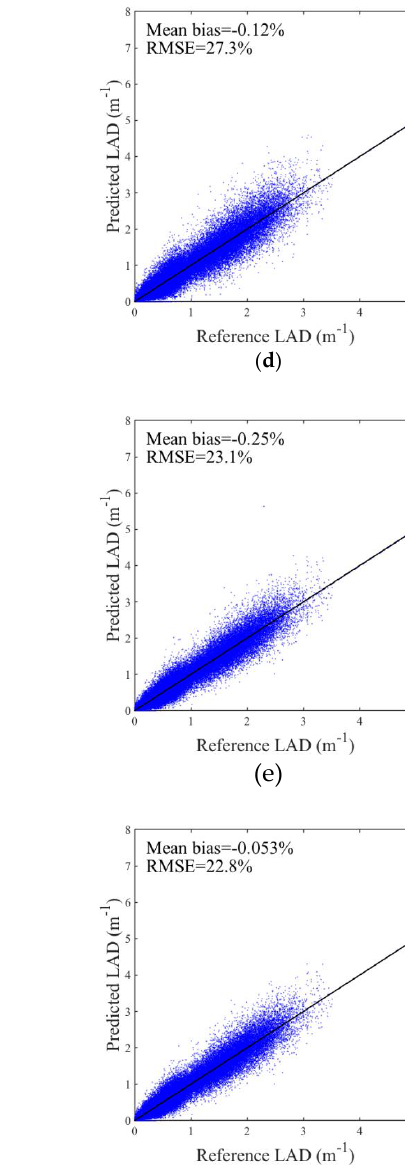
Nmax NW M (cid:93) (cid:93) (cid:93) LAD , N ∈ [ 5,15 [ ; ( b ) LAD , N ∈ [ 5,15 [ ; ( c ) LAD , N ∈ [ 5,15 [ ; NW M (cid:93) (cid:93) LAD , N ∈ [ 100,500 [ ; ( f ) LAD , N ∈ [ 100,500 [